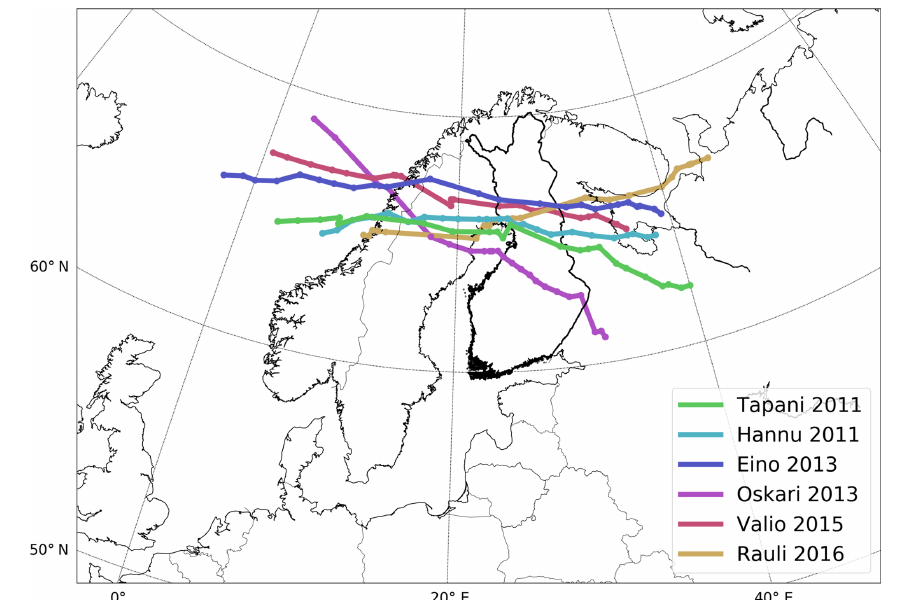
Figure 1. Storm tracks for the six typical windstorms affected Finland during the 2010s. Table 2. Volume of forest damage as a function of maximum wind gust speed (WGmax) according to Eq.